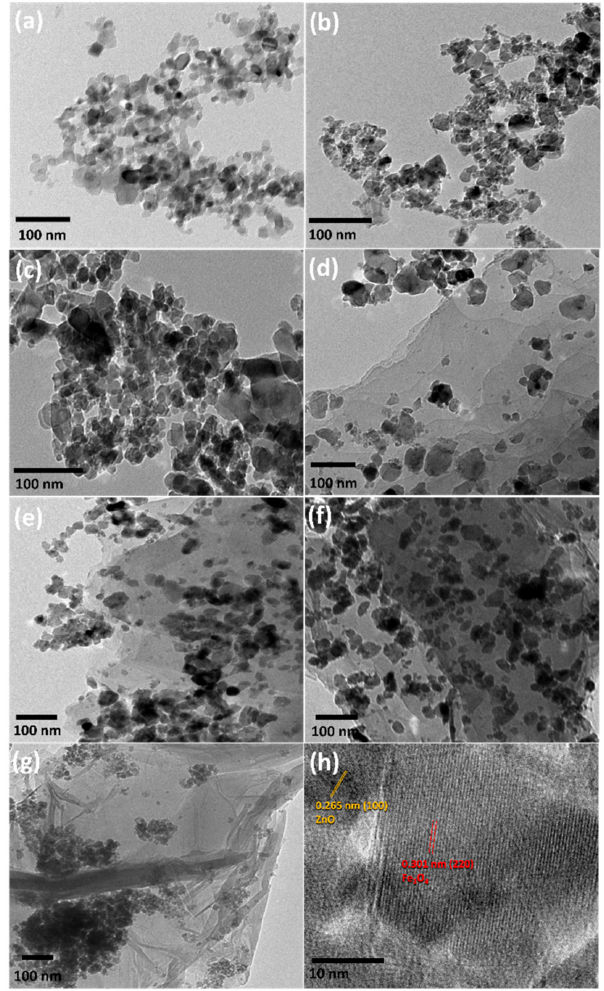
Figure 4. TEM images of Z ( a ), M ( b ), MZ ( c ), MZG1 ( d ), MZG2 ( e ), MZG3 ( f ), MZG4 ( g ), and a high-resolution transmission electron microscope (HRTEM) image of MZG3 ( h